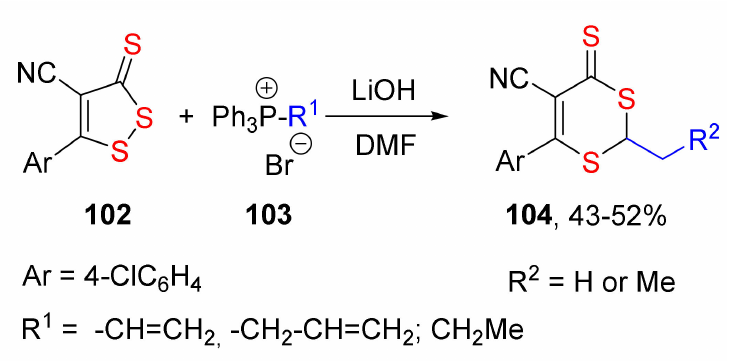
Scheme 59. Synthesis of 1,3-dithiine 4-thione 104